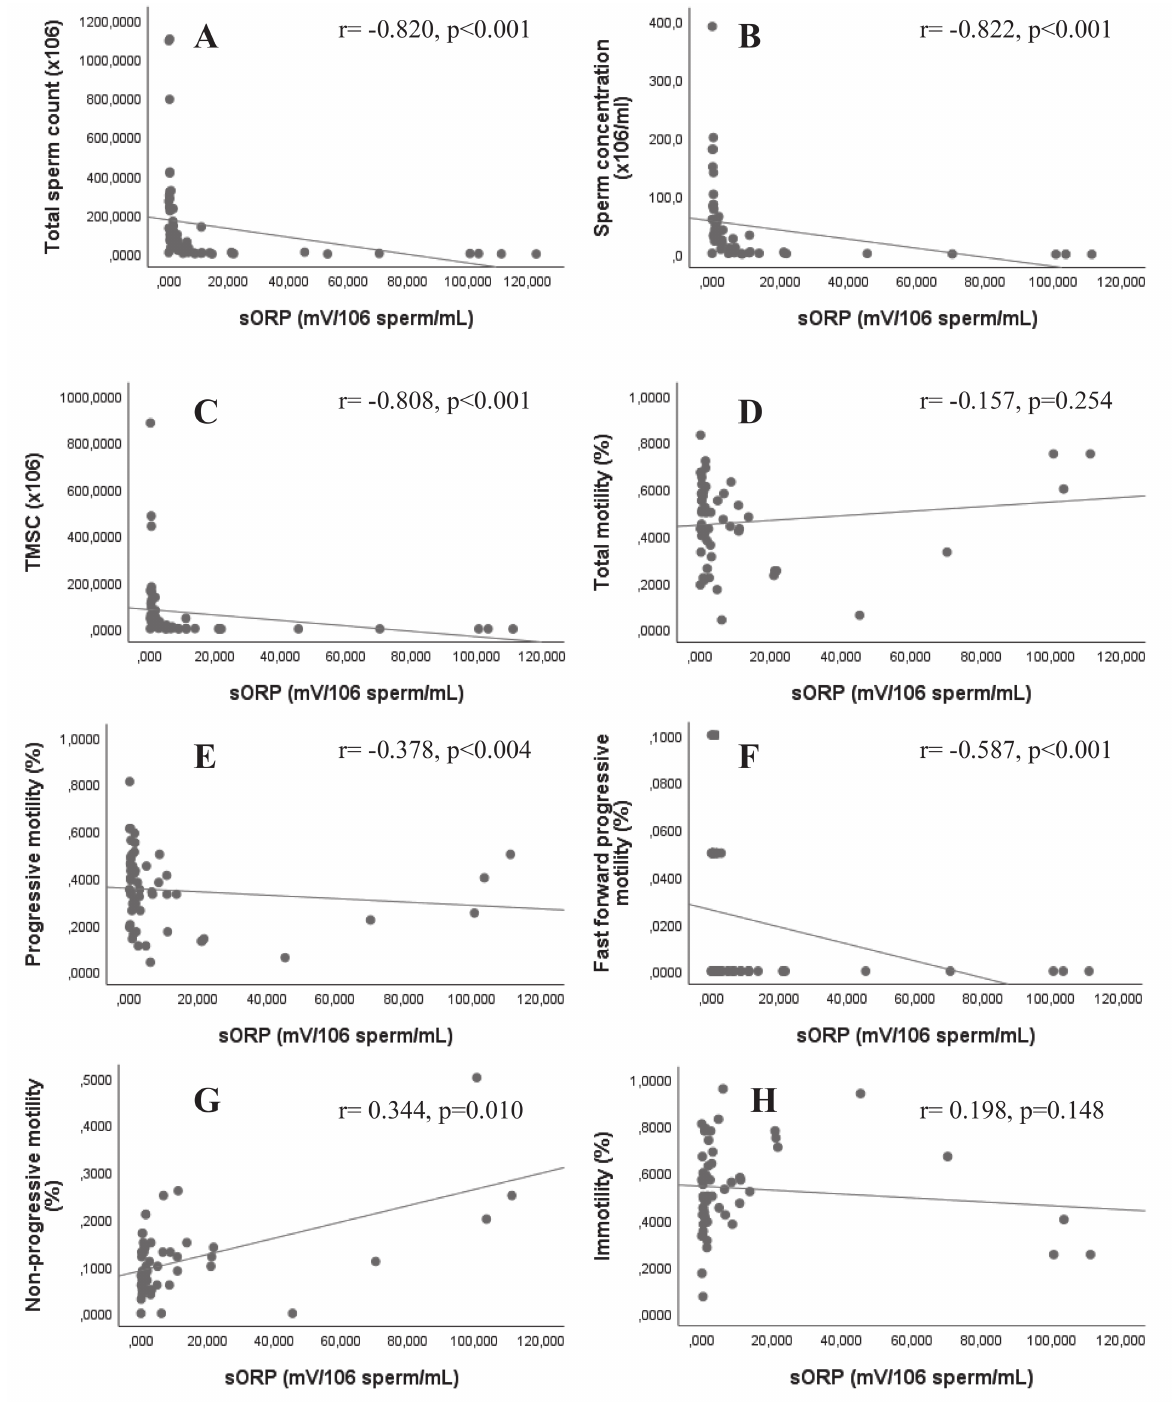
Figure 1 - Correlation of static oxidation reduction potential (sORP) with sperm parameters. A: total sperm count, B: concentration, C: total motile sperm count (TMSC), D: total motility, E: progressive motility, F: fast forward progressive motility, G: non progressive motility, H: immotility. sORP negatively correlates with total sperm count, sperm concentation, TMSC, progressive and fast forward progressive